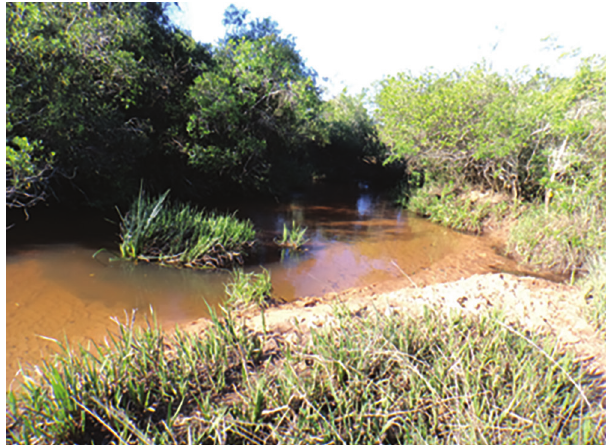
Fig 6. Type locality of Ituglanis inusitatus , new species: arroio São João, Alegrete, rio Ibicuí basin, Rio Grande do Sul State,